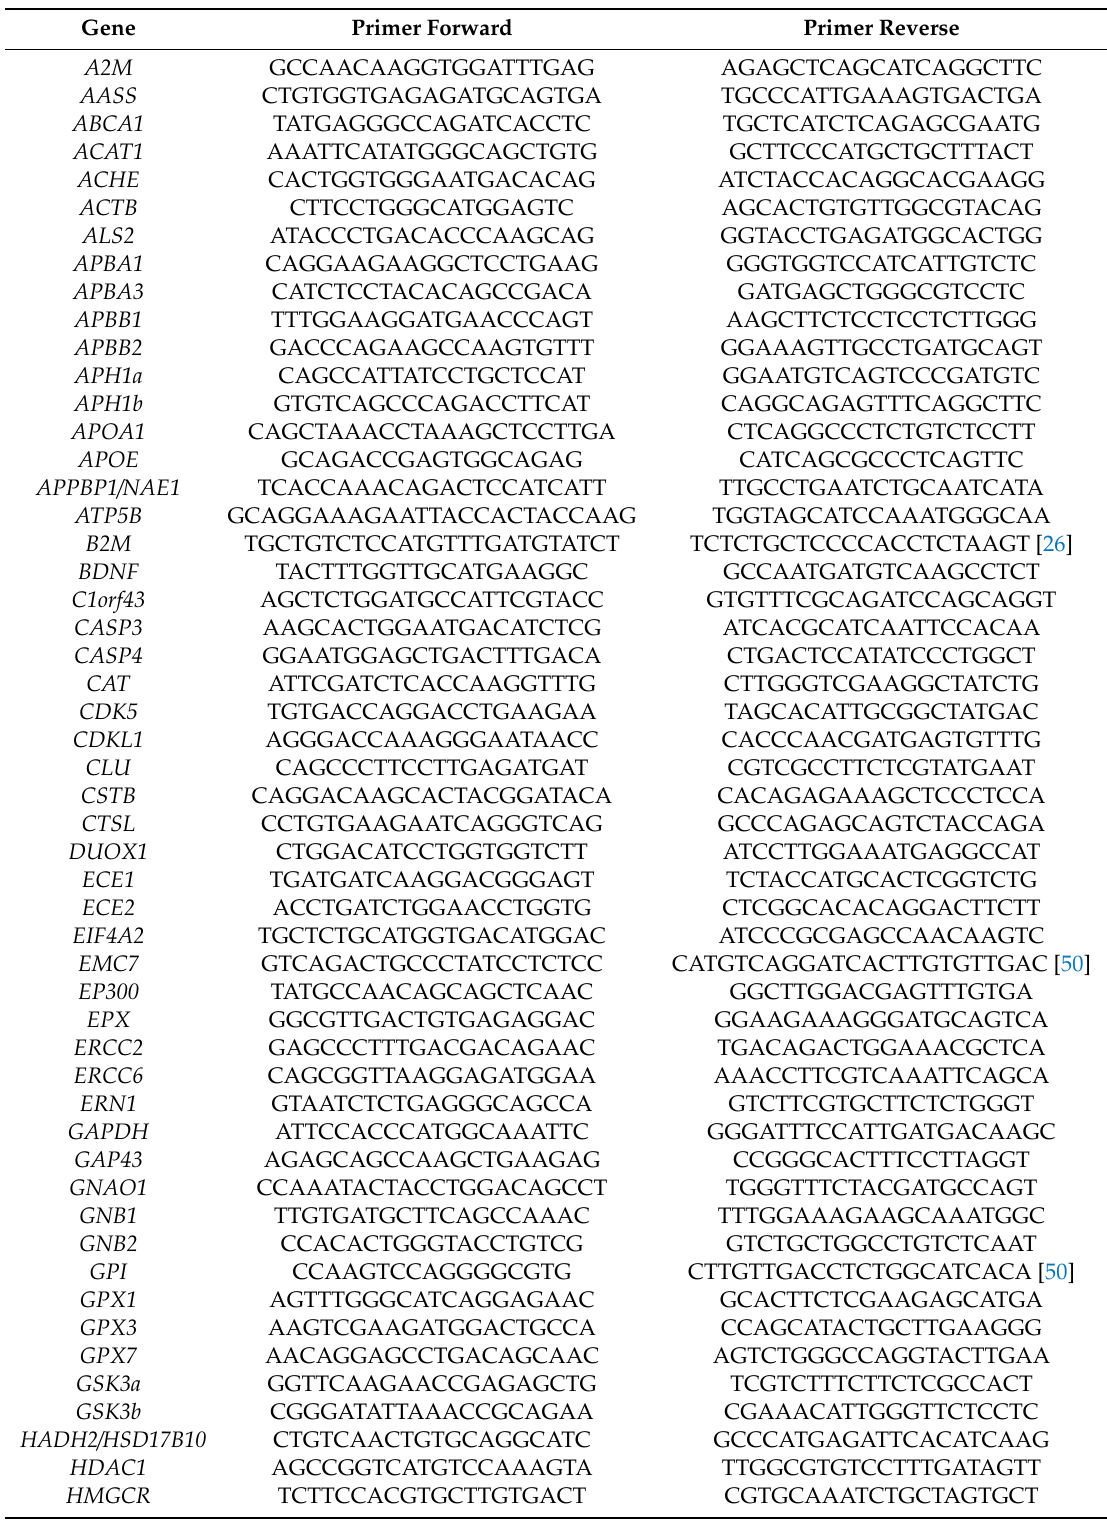
Table 1. RT-PCR primers